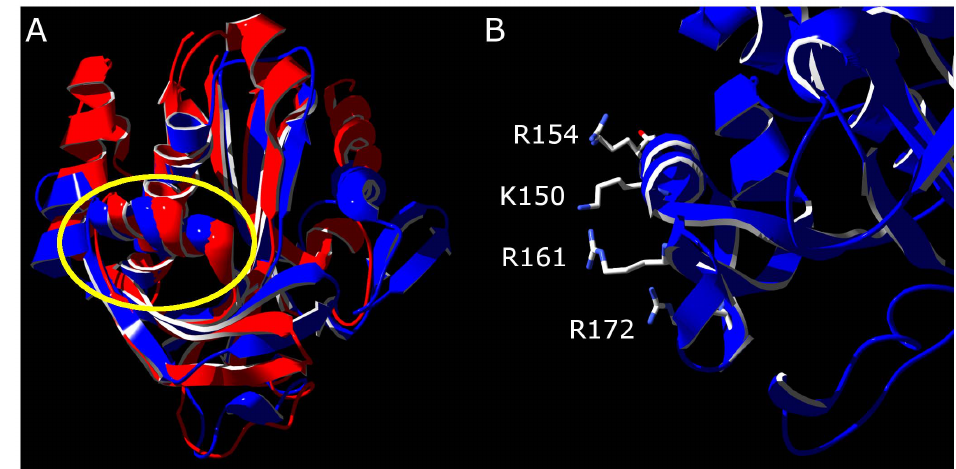
Figure 3. Structures of the acyl-substrate recognition motif. A) Alignment of the crystal structures of LasI (1R05 in blue) [18] and EsaI (1KZF in red) [19]. The two structures have a root-mean-square deviation of 1.45 A˚ for 124 amino acid a carbons. The conserved a -helix proposed to interact with ACP is circled in yellow. The active site cleft is behind this helix next to the conserved b -sheet. B) The LasI structure rotated 90 u about the Z axis with positively-charged residues in the motif displayed.